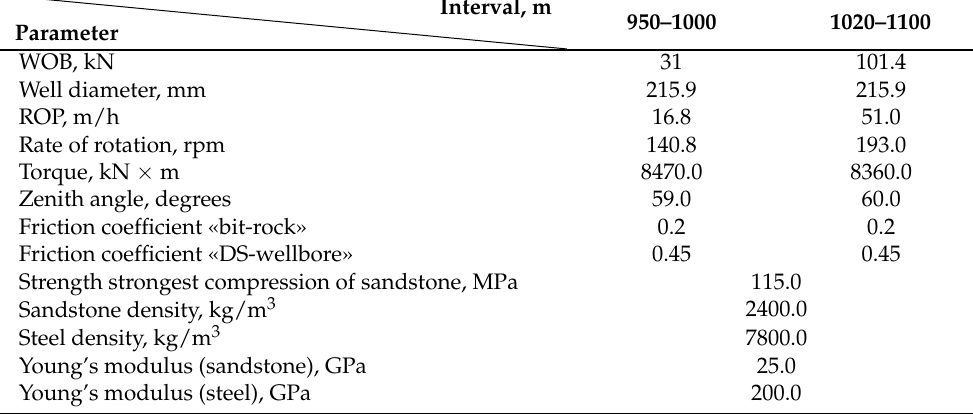
Table 3. Calculation